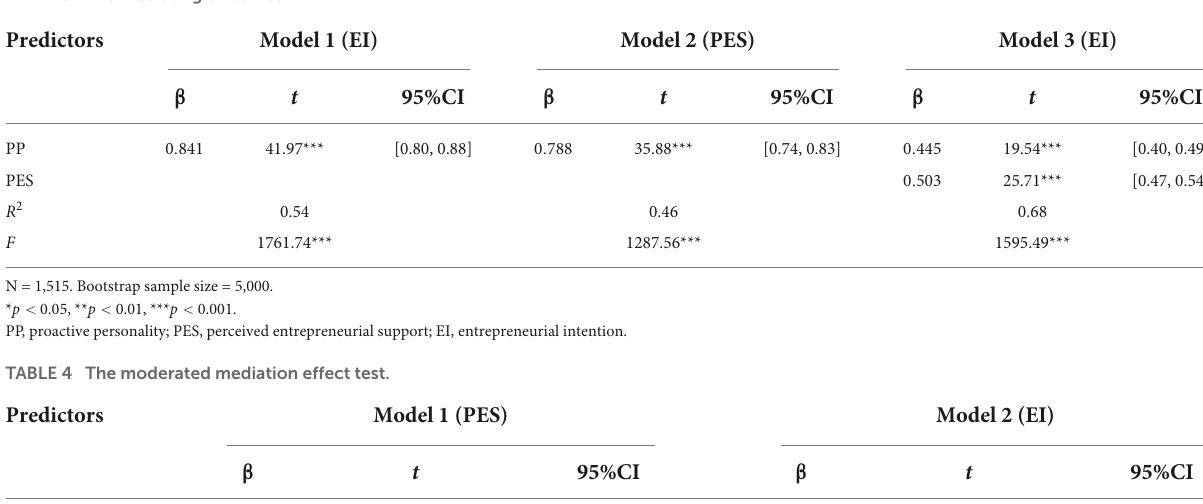
TABLE 3 The mediating effect test.